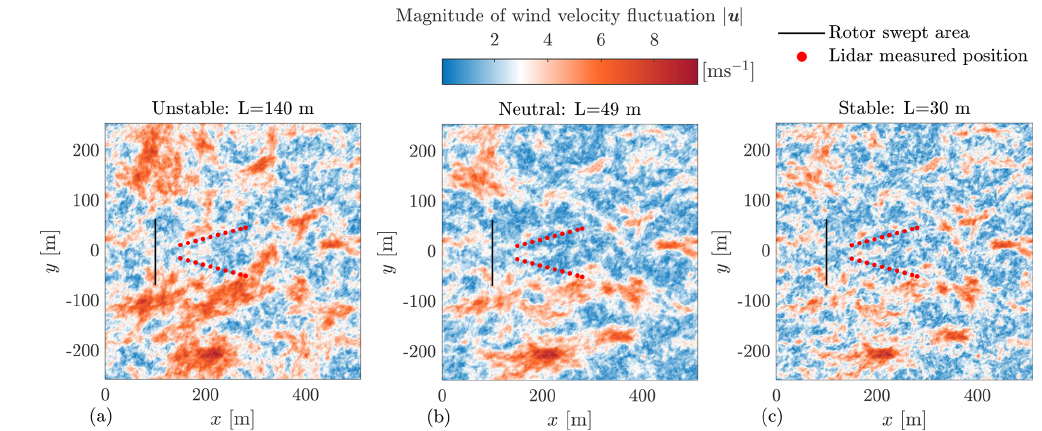
Figure 1. Top view of a turbulence field showing the eddy structures under different atmospheric stability, simulated using the 4D Mann Turbulence Generator with parameters listed in Table 1. The lidar measured positions are plotted based on a typical four-beam pulsed lidar. The rotor-swept area is drawn based on the NREL 5.0MW reference wind turbine which has a rotor diameter of 126m. The length scales L are chosen based on studies by Peña (2019) and Guo et al.